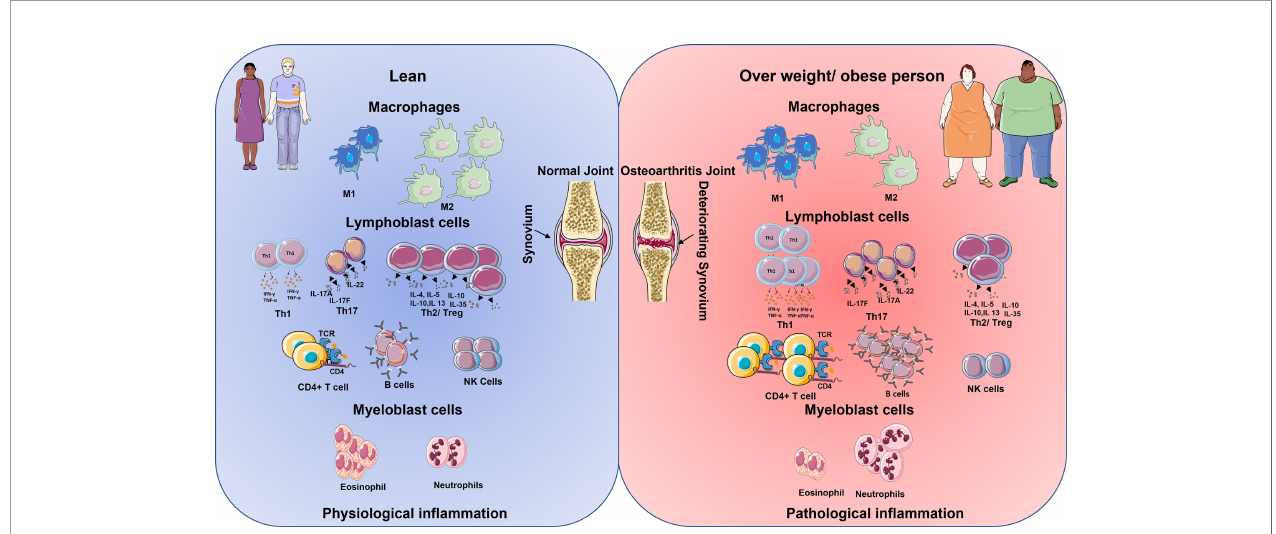
FIGURE 1 | Schematic diagram shows the immune cell being up and downregulated in lean and overweight/obese individuals. The cells on the left represent the lean physiological aspects of the immune system and on the right, the obese immune system (24). In lean population during in fl amed condition the macrophages M1 cells are lower in comparison to M2 cells. However, the reverse is seen in the obese in fl ammation. Lymphoblastic cells like Th1, Th17, T helper, and B cells are lower in comparison with Treg cells and NK cells in lean in fl ammation population. However, in obese population, there is an increase in the production of Th1, Th17, T helper cells, B cells but reduction in the number of T reg cells and NK becomes low. Granulocytes like the eosinophiles are higher in comparison with neutrophiles in lean in fl ammation condition, however, the reverse is observed with obese population in their in fl ammatory